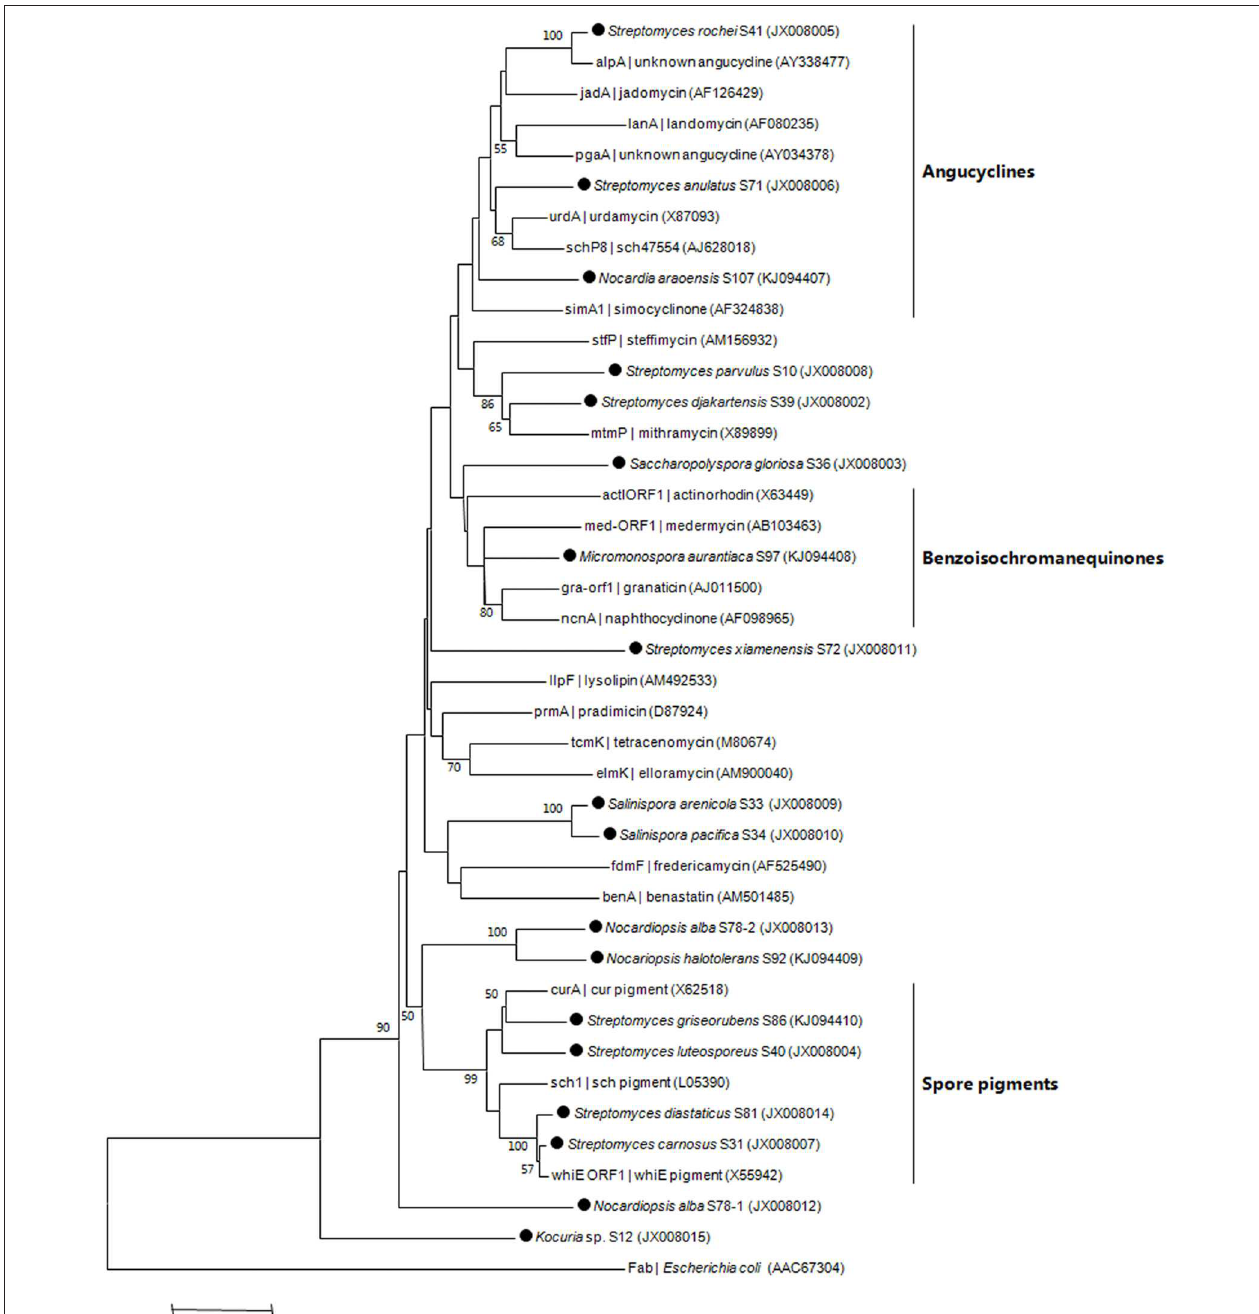
FIGURE 2 | Neighbor-joining tree constructed using aligned KS α domain amino acid sequences (203 amino acid positions). The sequences obtained in this work are marked by black dot. Next to the KS α gene name, the identified, or predicted compounds and GenBank accession number of the gene cluster are indicated. Boot strap values calculated from 1000 resamplings using neighborjoining are shown at the respective nodes when the calculated values were 50% or greater. The scale bar represents 0.1 substitutions per amino acid